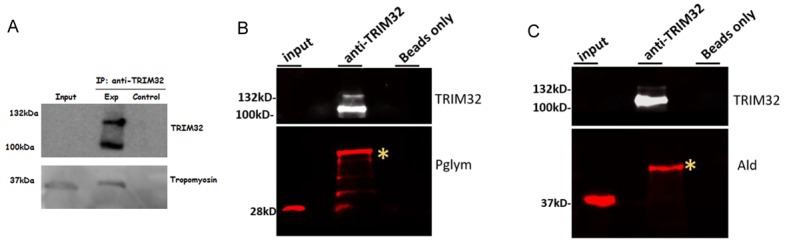
Reviewer Figure 1.